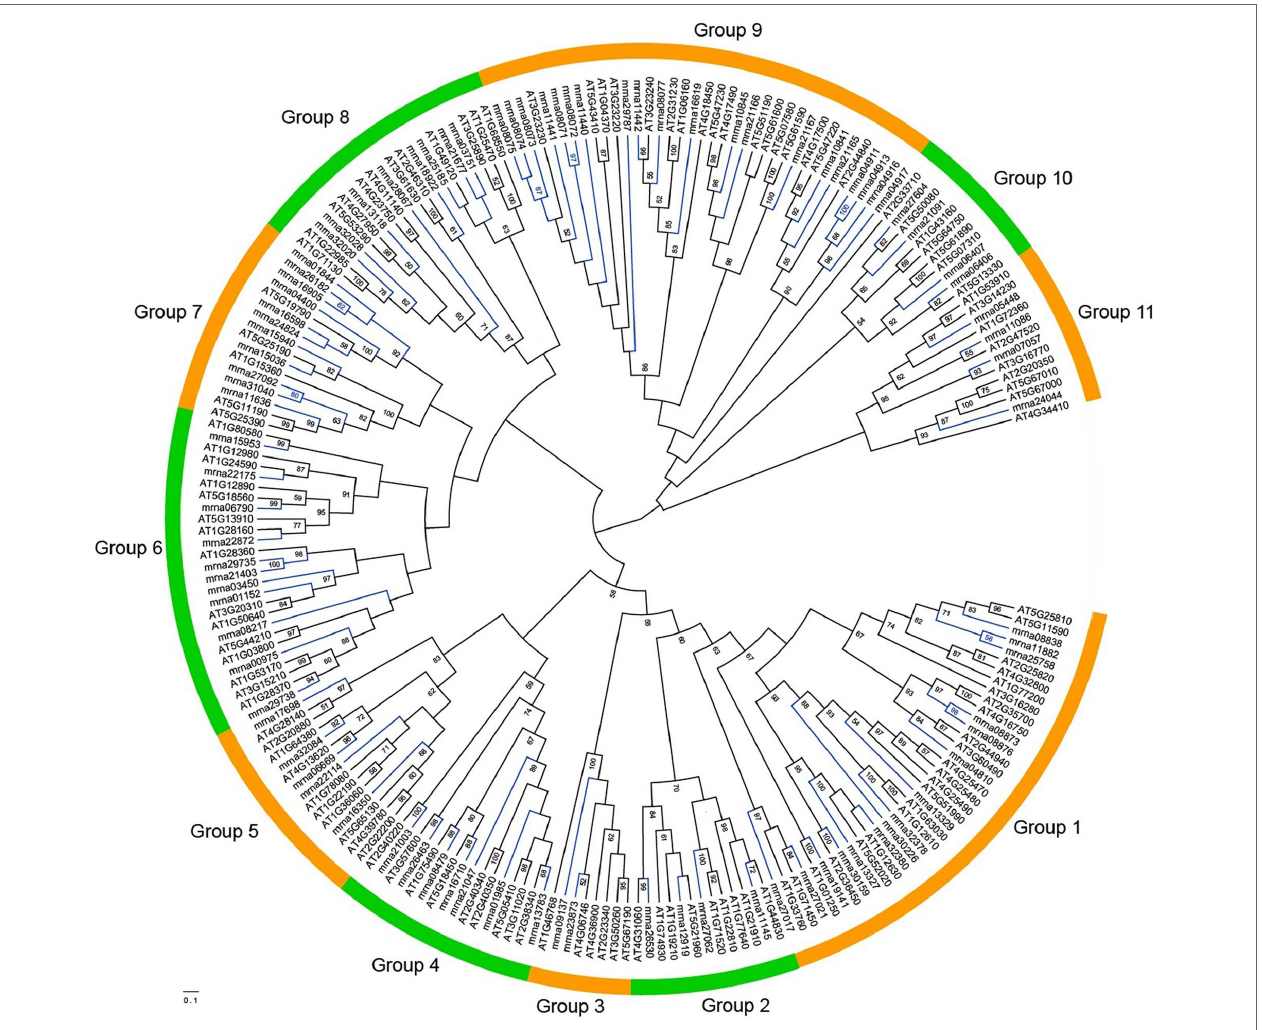
FIGURE 2 | Maximum-likelihood phylogeny of the ERF proteins from Fragaria vesca and Arabidopsis thaliana . The phylogeny was constructed based on the amino acid sequences of full-length FveERF and AtERF proteins with 100 bootstrapping replicates. Bootstrap values greater than 50 are indicated on the nodes. Green and orange arcs indicate different groups of ERF proteins. Blue and black branches represent FveERF and AtERF proteins,